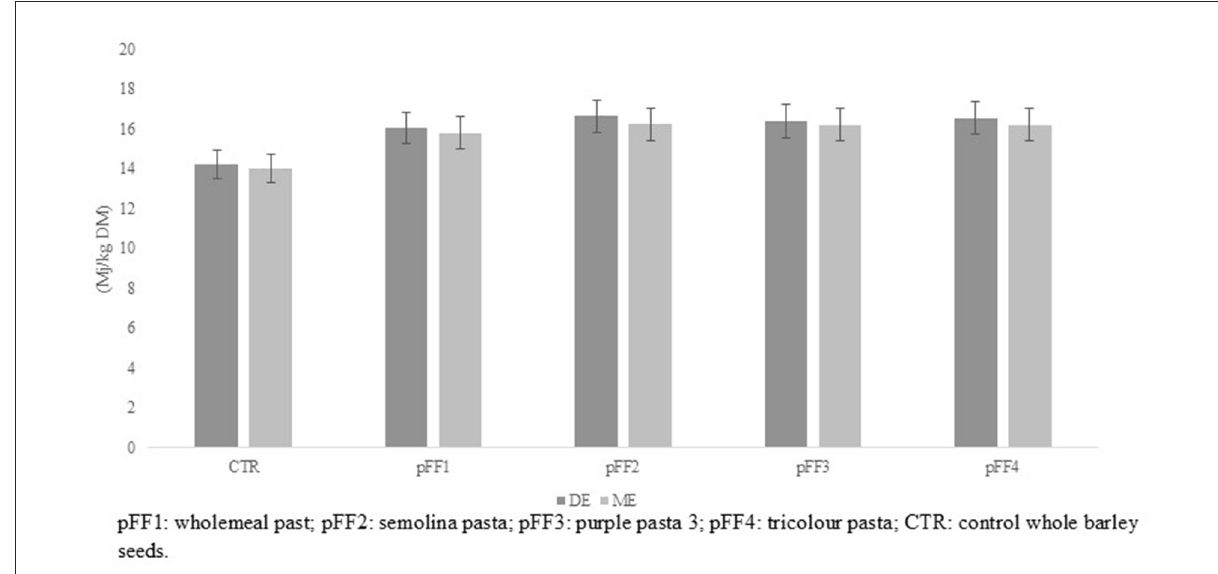
FIGURE1 Digestible (DE) and metabolizable (ME) energy content of barley (control) and pasta former foods (pFFs).